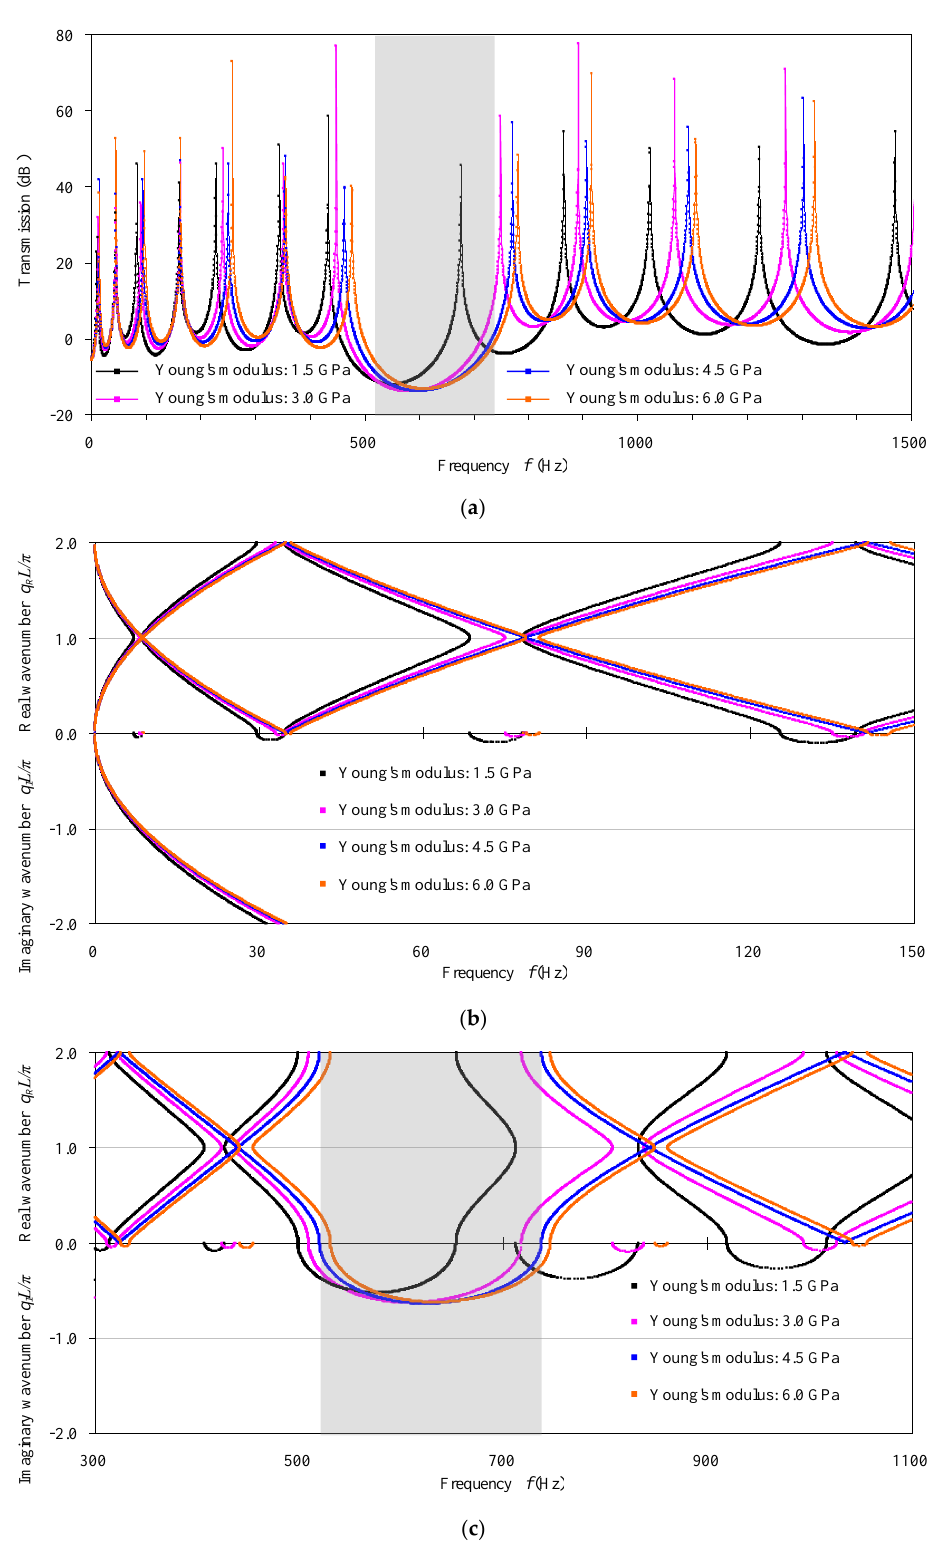
Figure 10. The transmission spectra and the band structures of the four phononic crystal beams with the PMMA beam in the fifth unit cell having cross-sectional height 8 mm , 12 mm , 15 mm , and 18 mm , respectively: ( a ) Transmission spectra within 1500 Hz f ≤ ; ( b ) Phase and attenuation constant spectra within 150 Hz f ≤ ; ( c ) Phase and attenuation constant spectra within 300 Hz 1100 Hz f ≤ ≤ .